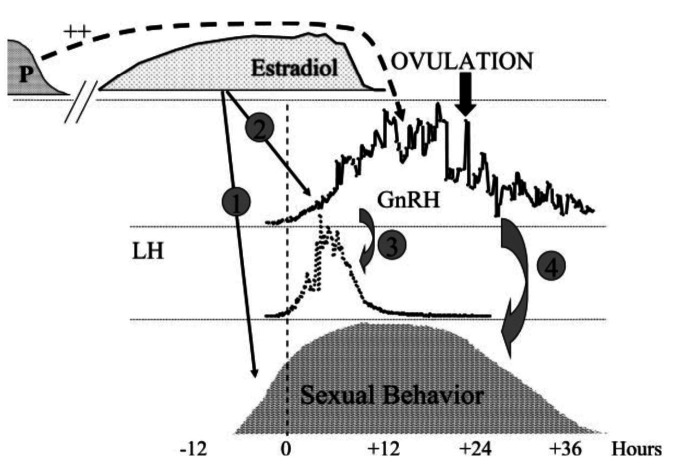
In the ewe at luteolysis, plasma progesterone decreases and oestradiol increases. Oestrus behaviour is initiated (1) when oestradiol reaches a threshold and remains high for 6–10 h. Simultaneously, oestradiol also induces a surge of GnRH in portal blood (2), and LH in the periphery (3). Co-incident with the LH surge, oestradiol declines to basal concentrations while GnRH secretion stays high for an additional 24–36 h, while oestrus behaviour continues (4). One role of progesterone priming (P) is to increase the magnitude of the GnRH surge (broken arrow). Ovulation (black arrow) is precisely timed occurring 22–26 h after the LH surge. Adapted from Caraty et al. (2002); reproduced with permission.